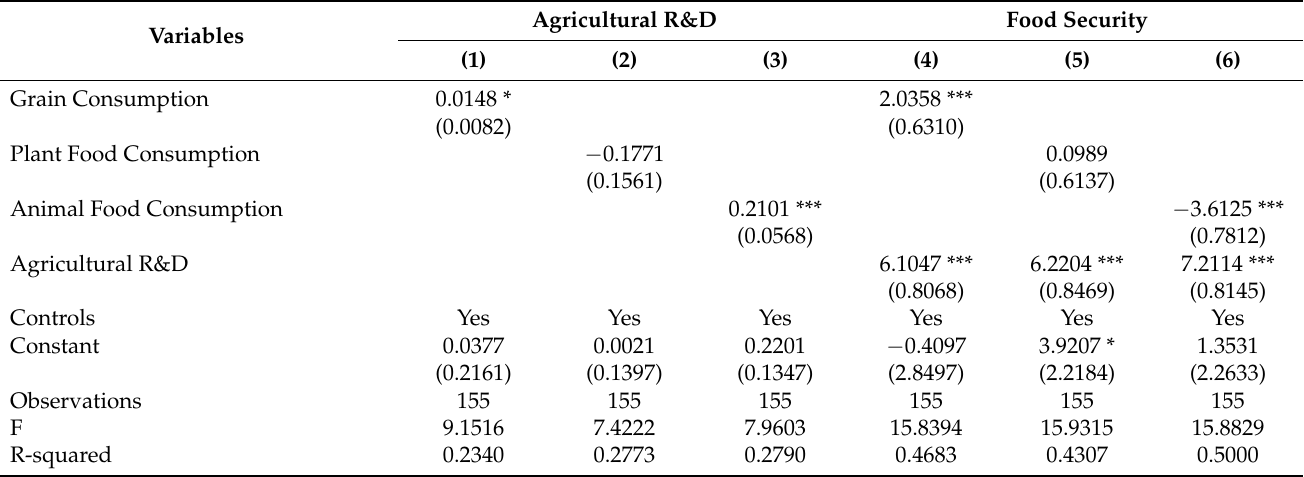
Table 6. The mediating role of agricultural R&D in the impact of food consumption structure on food security.